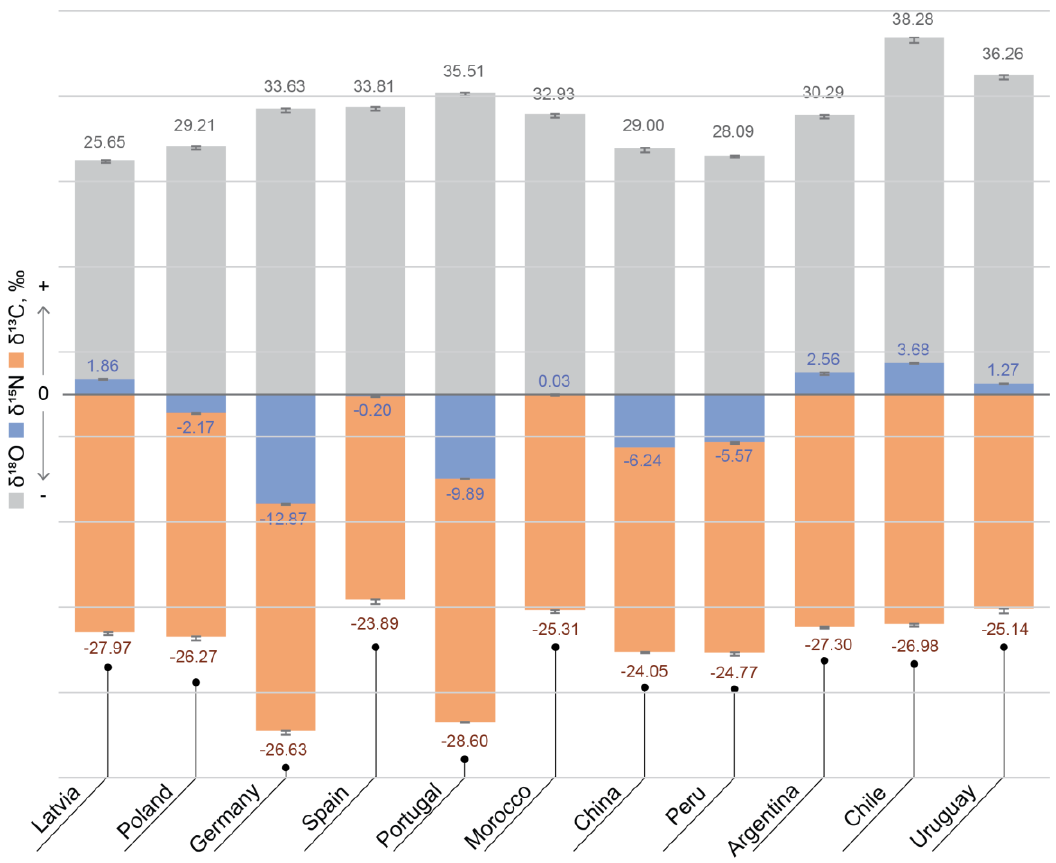
Figure 2. Light stable element isotope (δ 13 C, δ 15 N, δ 18 O) ratio values in blueberries from different countries.